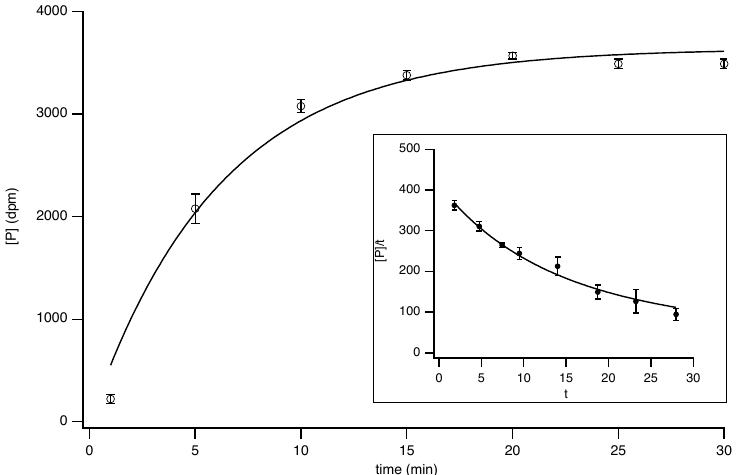
Figure 2. Time-course of the oxidation of 2-phenylethylamine by monoamine oxidase-B. Activity was determined by a radiochemical procedure. Each point is the mean ± s.e.m. from three determinations, with some points at longer times omitted. The inset shows a representative plot of [P]/time against time to determine the initial